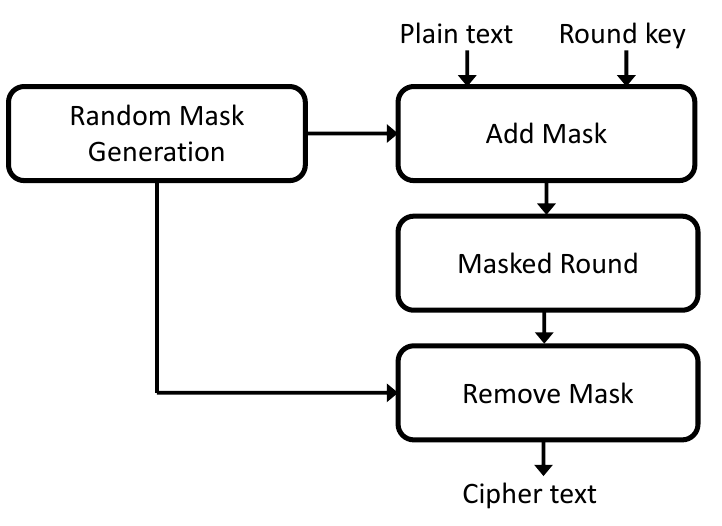
Figure 5. Masking step on